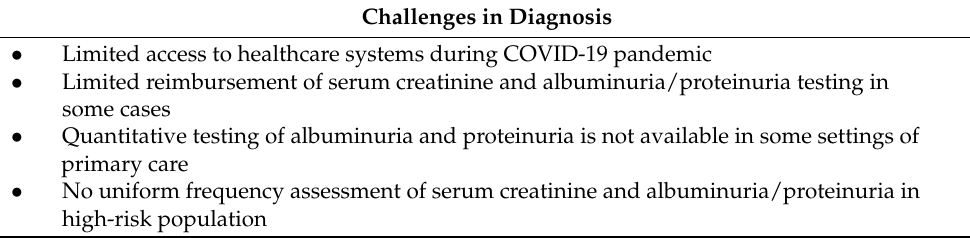
Table 3. Current challenges in diagnosis and treatment of CKD in the Balkan